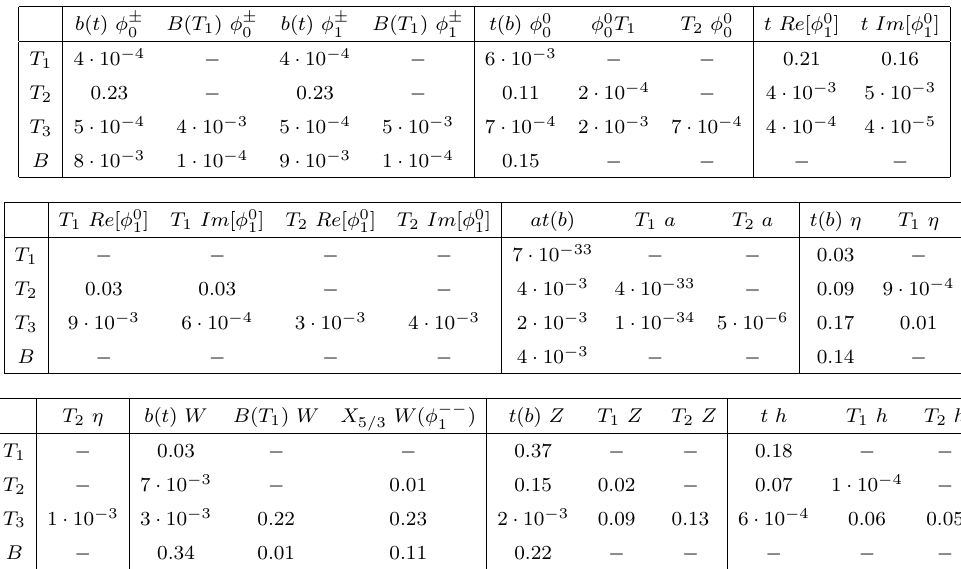
Table 4 . Branching ratios of the VLQs in the benchmark scenario Bm4 for (cid:12)xed values of the